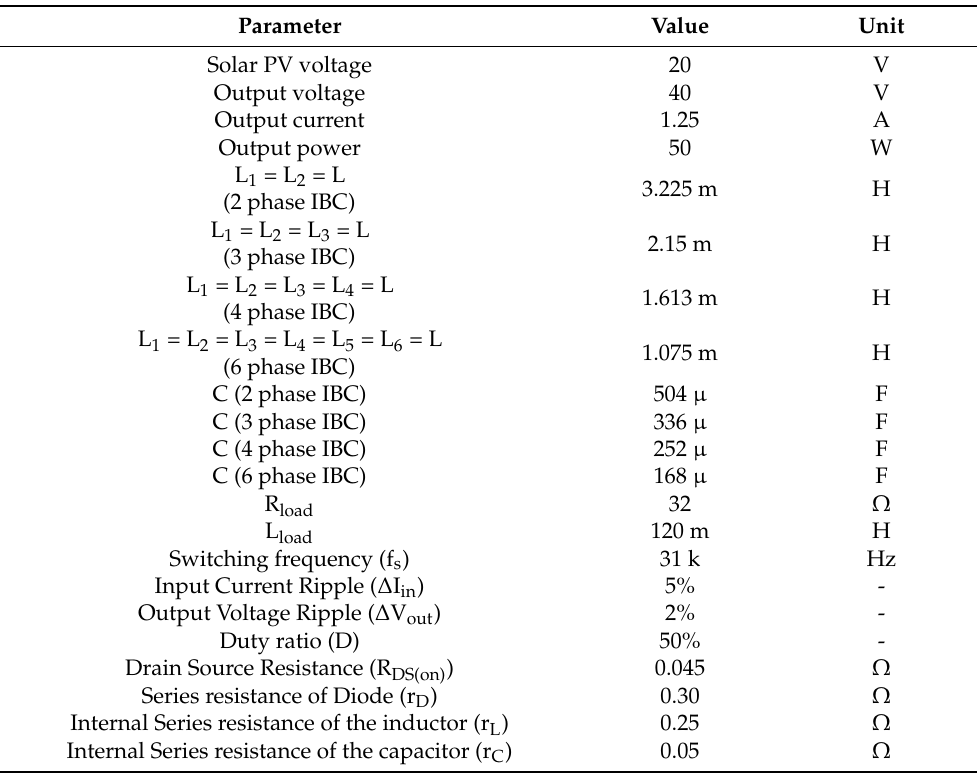
Figure 1. N phase IBC schematic diagram. Table 3. Parameter values of